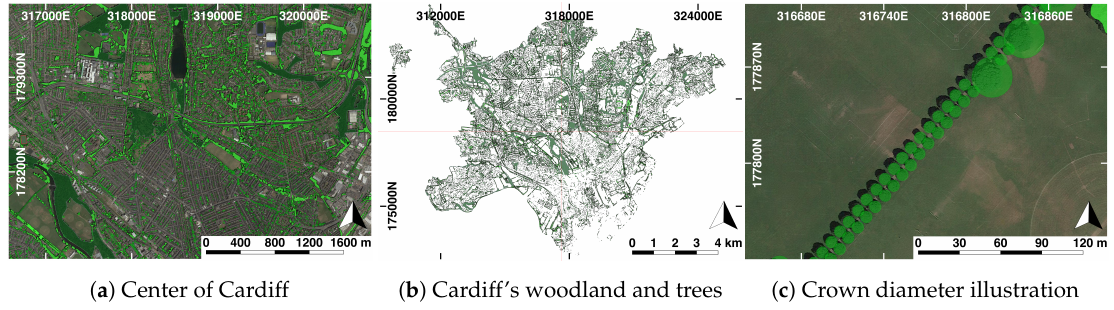
Figure 1. Natural Resources Wales (NRW) Dataset—Distribution and Coverage. Note: Satellite imagery copyright